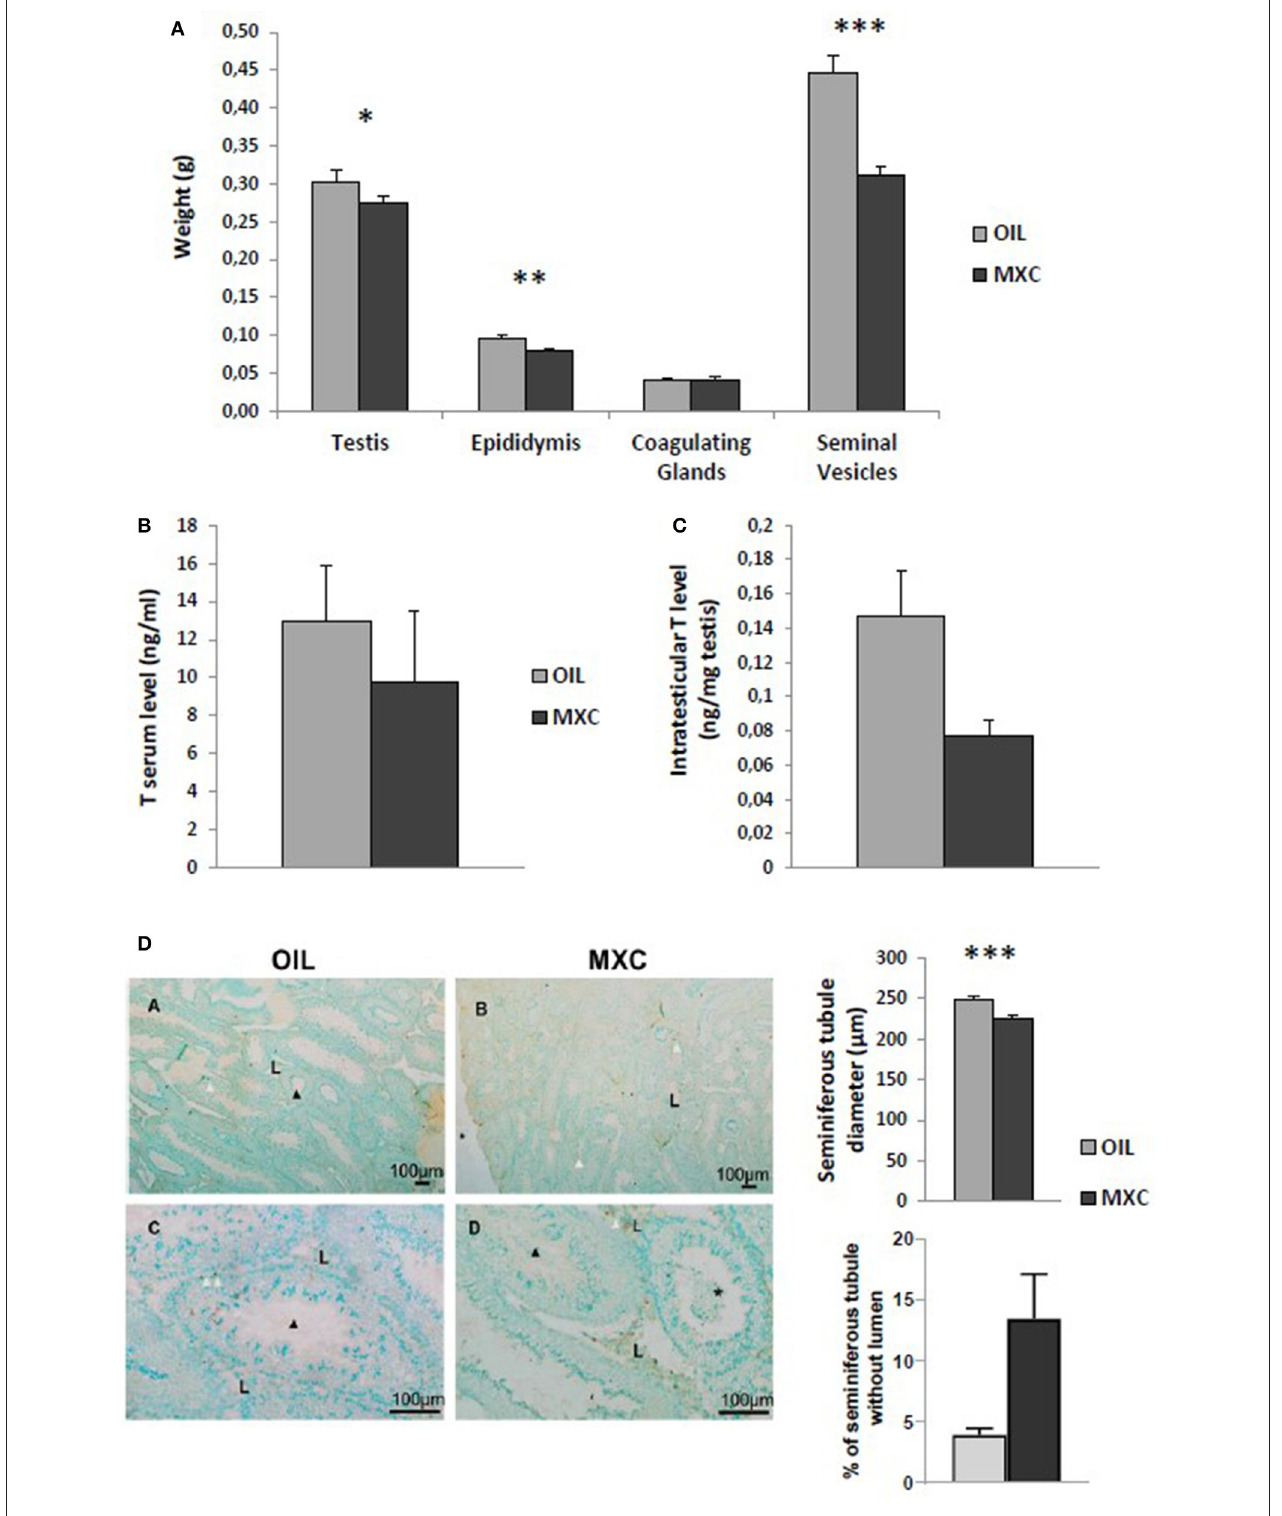
FIGURE 3 | Effect of perinatal exposure to MXC on male reproductive parameters. MXC exposure induces a lower weight of some reproductive organs such as epidydimis or seminiferous vesicles (A) . When measuring testosterone (T) levels in both serum (B) and testes (C) , a significant difference was only observed only in